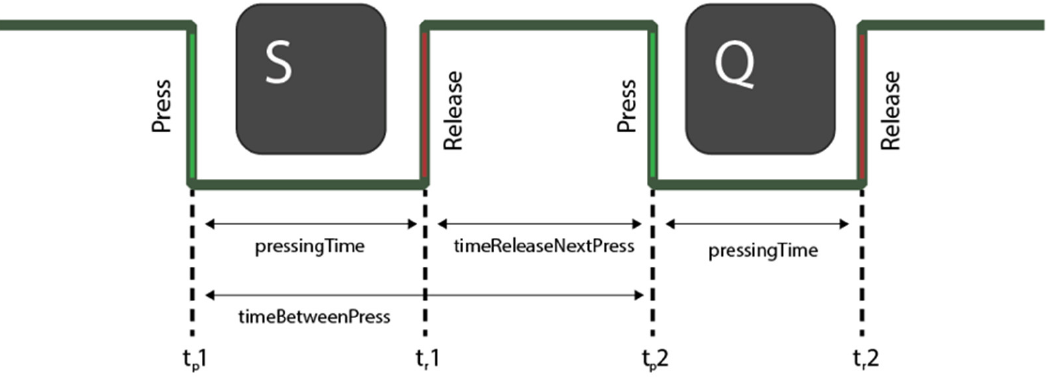
Figure 1. Keystroke mechanics of this study.